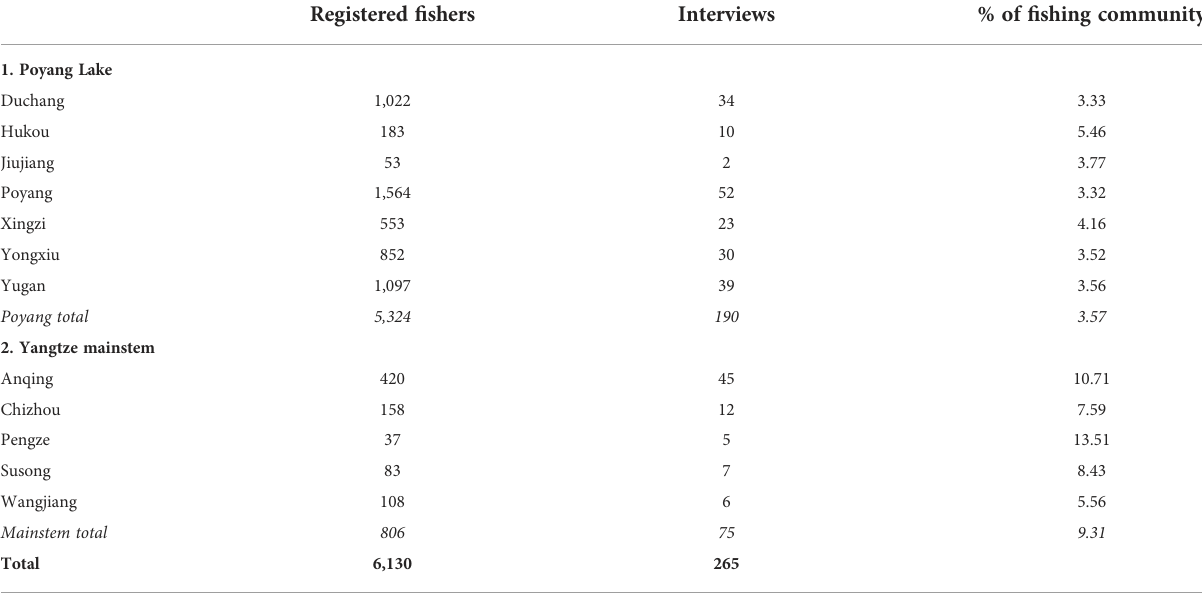
Bold values indicate subsections and summary row within